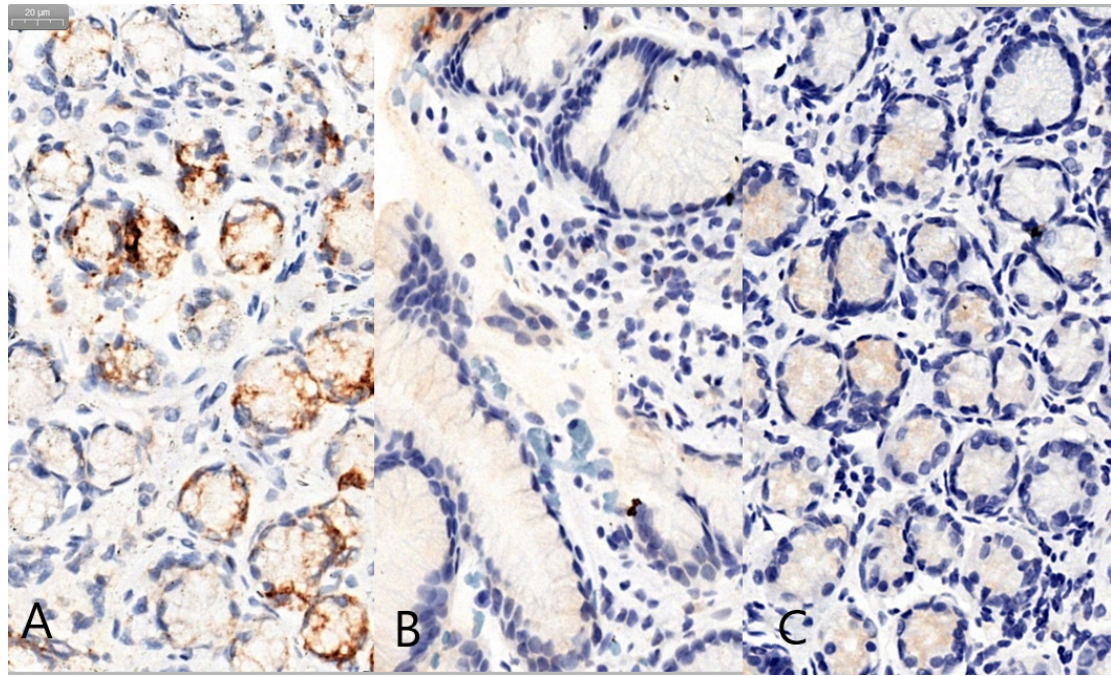
Figure 2. Examples of aberrant mucin expression (40 × objectiveX): glandular expression of MUC5AC ( A ), foveolar / superficial expression of MUC6 ( B ) and glandular expression of MUC2 in the gastric epithelium ( C